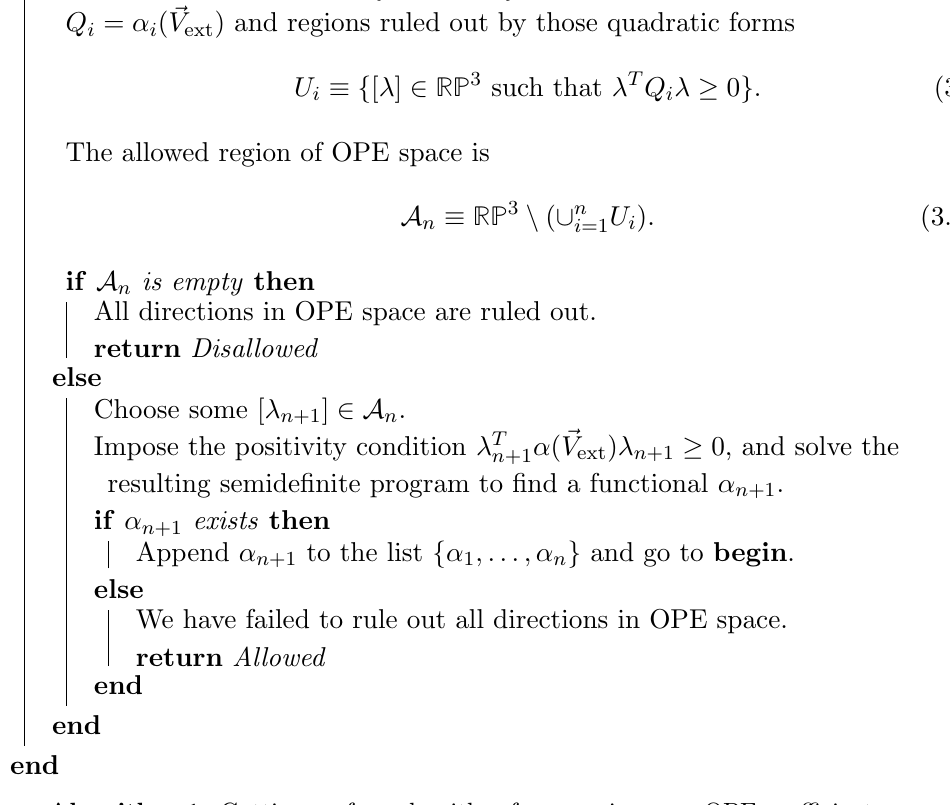
Algorithm 1 . Cutting surface algorithm for scanning over OPE